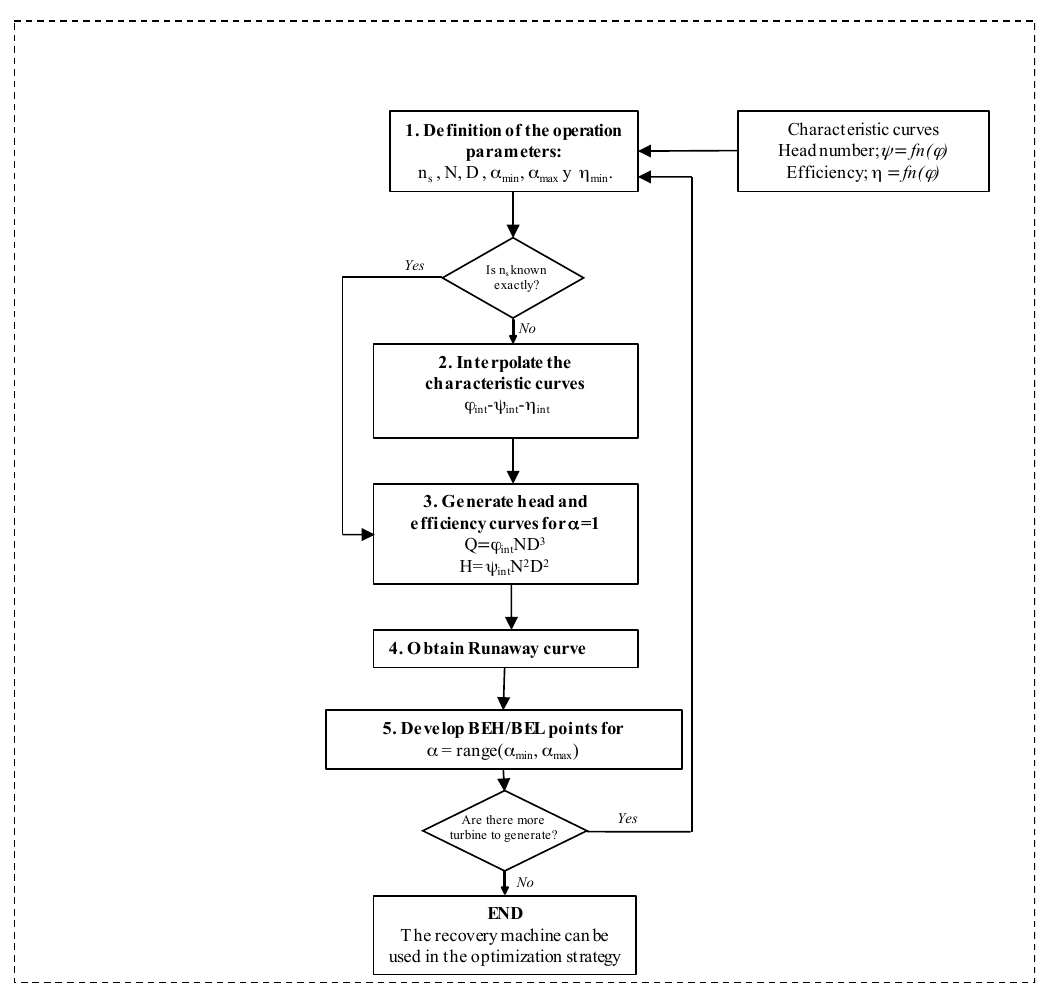
Figure 3. Scheme of the operation of the turbine (PAT) module.